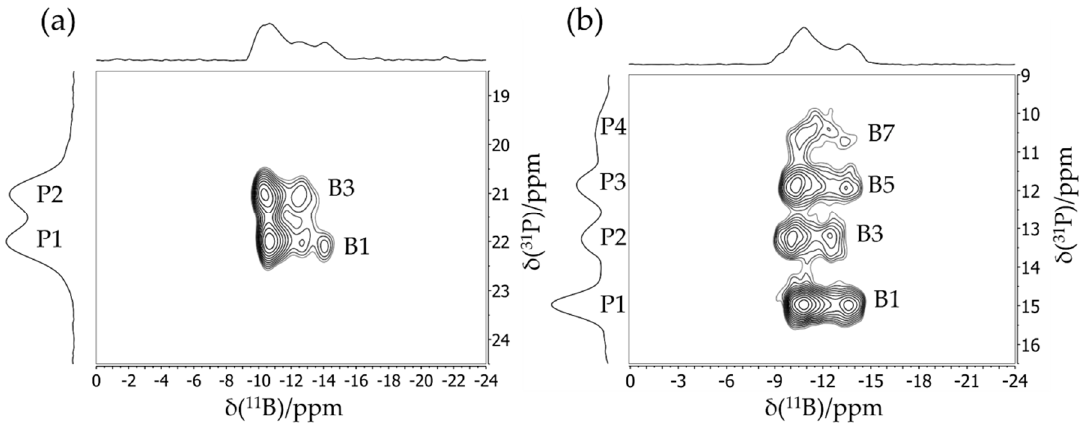
Figure 21. 11 B{ 31 P} CP/refocused INEPT MAS NMR spectra of ( a ) 4 and ( b ) 5 . The sites P4 and B7 in ( b ) arise from an impurity.